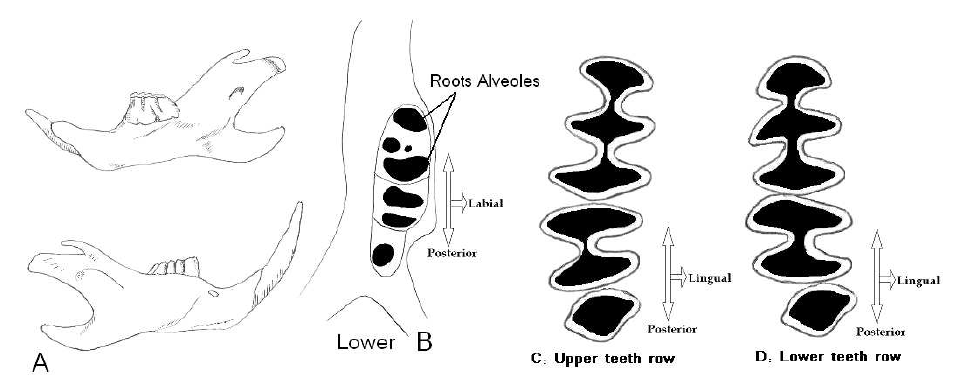
FIGURE 2 : A) Mandible B) Lower mandible, root alveolus C) Upper D) lower teeth rows in Meriones .